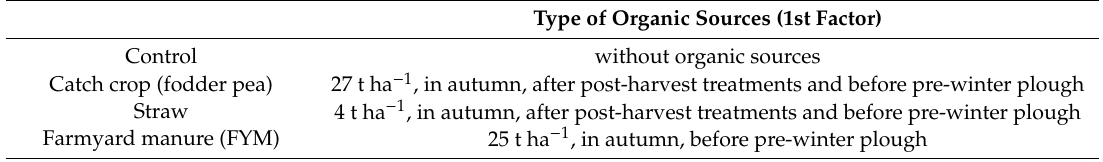
Table 1. Experimental treatments.